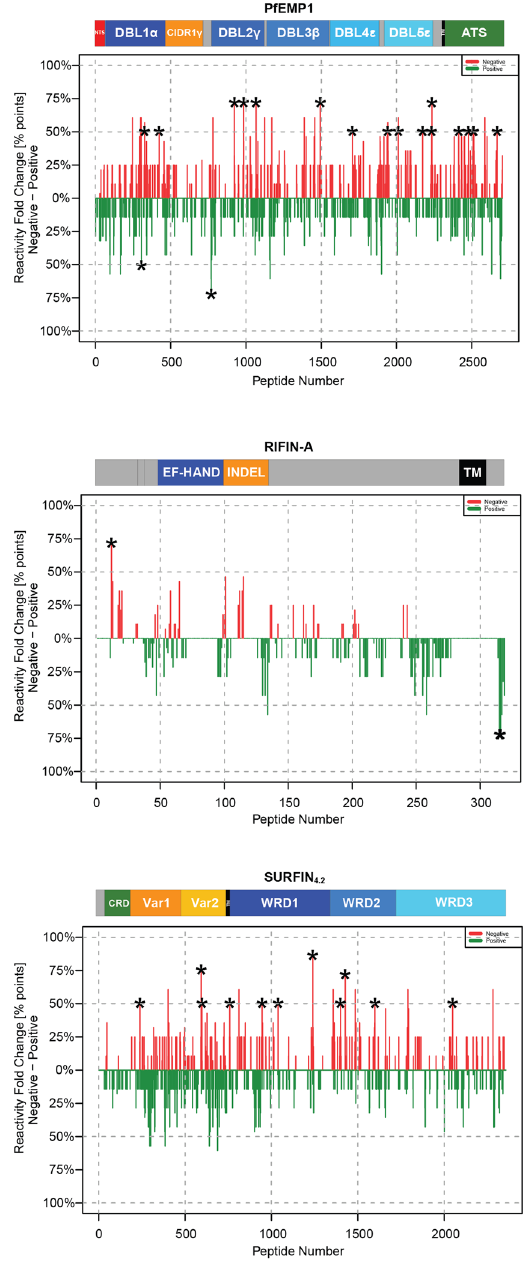
Figure 5. Pediatric sera reactivity against three surface proteins. A small subset of samples was selected and tested on a peptide array including three surface proteins. The samples analyzed were divided according to their ability to disrupt rosettes (of parasites grown in group O RBCs), with 7 being positive (in green) while 4 were considered negative (in red) for this assay. The stars indicate peptides differentially recognized between the two groups with an α ≤